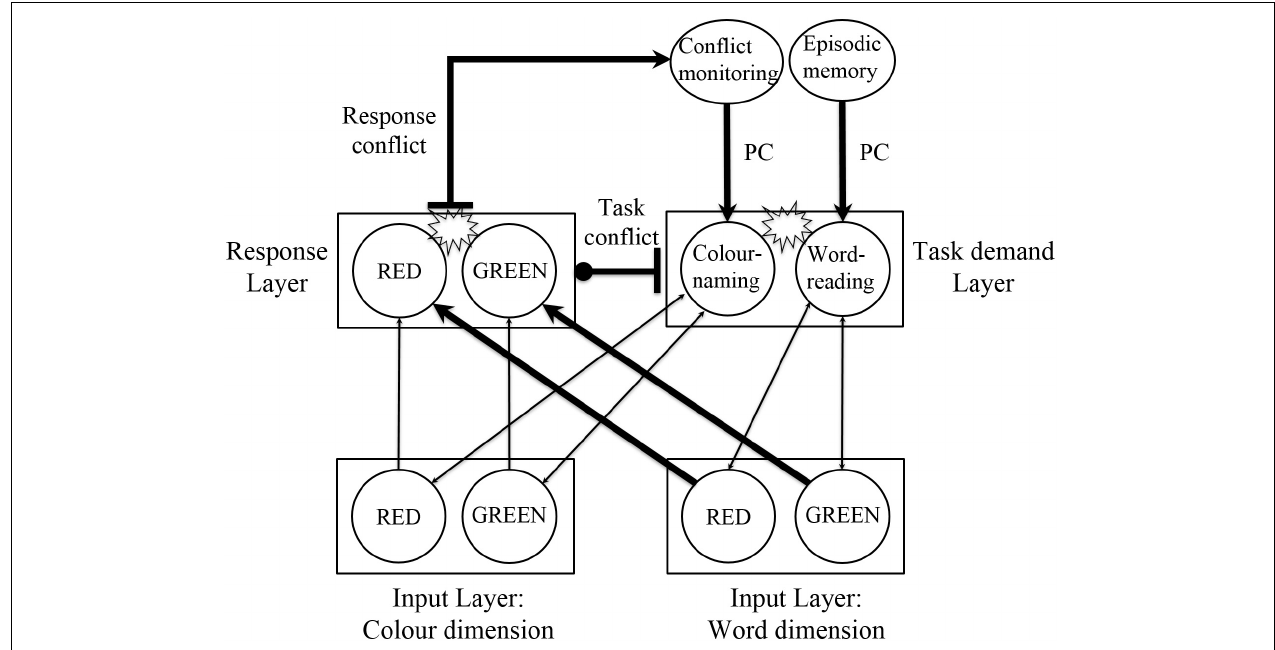
FIGURE 1 | Proactive-control/task-conflict (PC-TC) model. Adapted from Kalanthroff et al. (2015). The task demand units are modulated by proactive control through the conflict monitoring node. The episodic memory node was not part of the PC-TC model and has been added to explain the current findings and those of Sharma